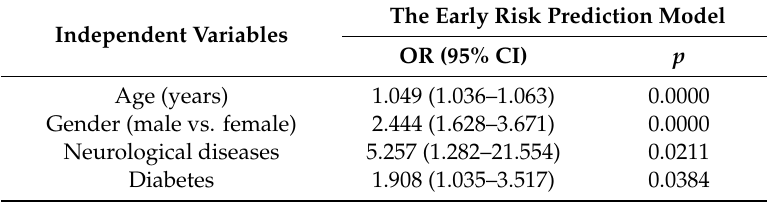
Table 4. Statistical significance of the factors in the regression model with early risk factors.